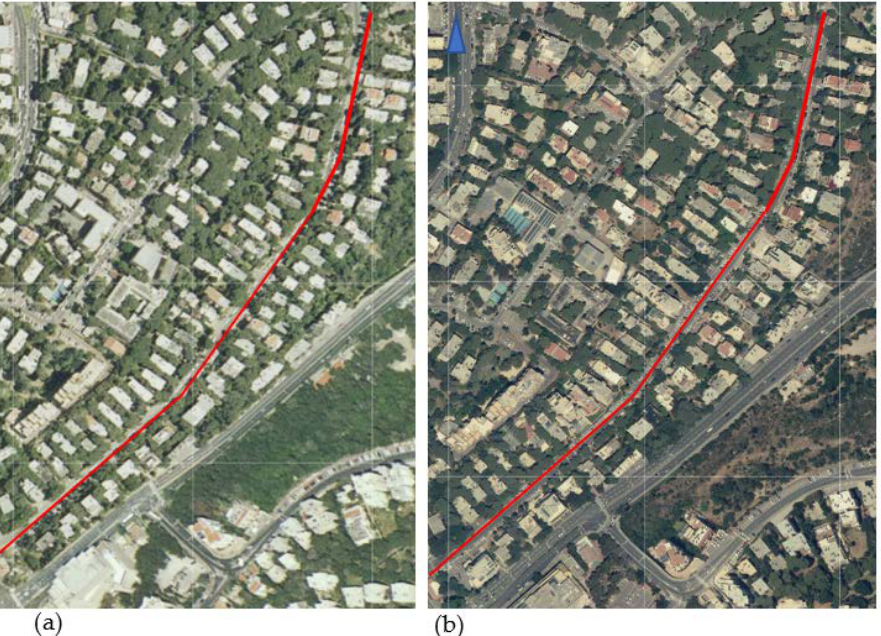
Figure 6. De-Israeli site before the urban renewal ( a ) and after the urban renewal ( b ). Source: ( a ) govmap, 2015; govmap, 2021, https://www.govmap.gov.il/.